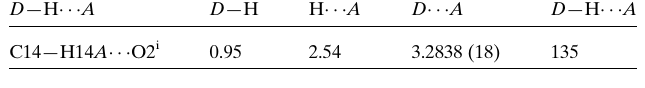
Table 2 Experimental details.